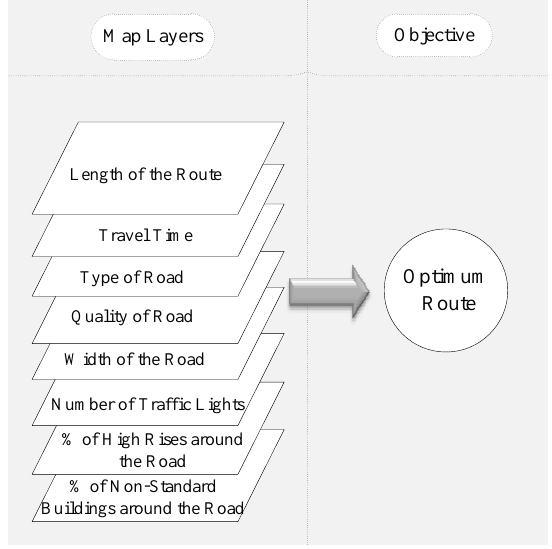
Figure 4. Contributing factors used in this